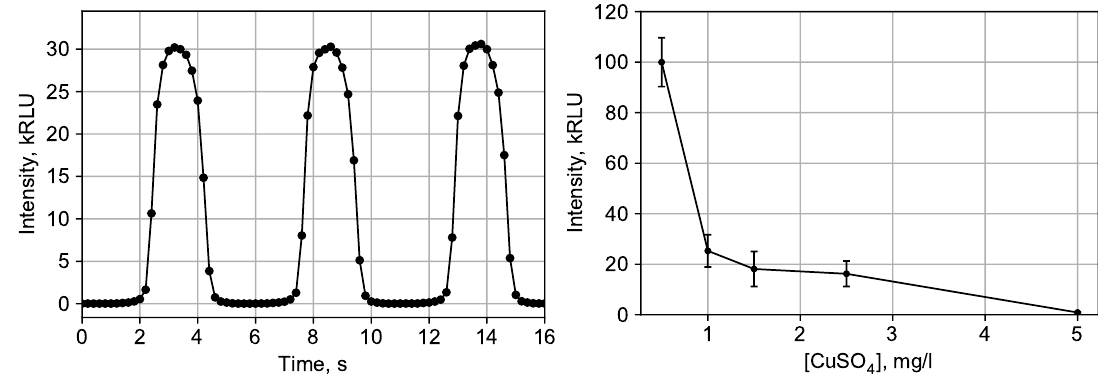
Figure 2. Signals from three droplets ( left ) and dependence of luminescence intensity on CuSO 4 concentration ( right